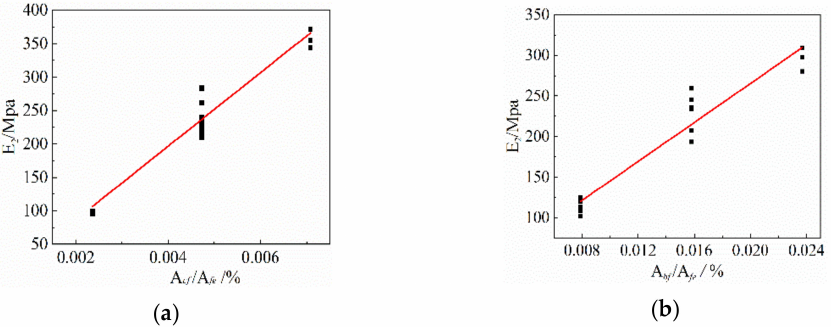
Figure 11. The relationship between the modulus of elasticity of FRP gird. ( a ) CFRP grid-reinforced ECC, ( b ) BFRP grid-reinforced ECC.